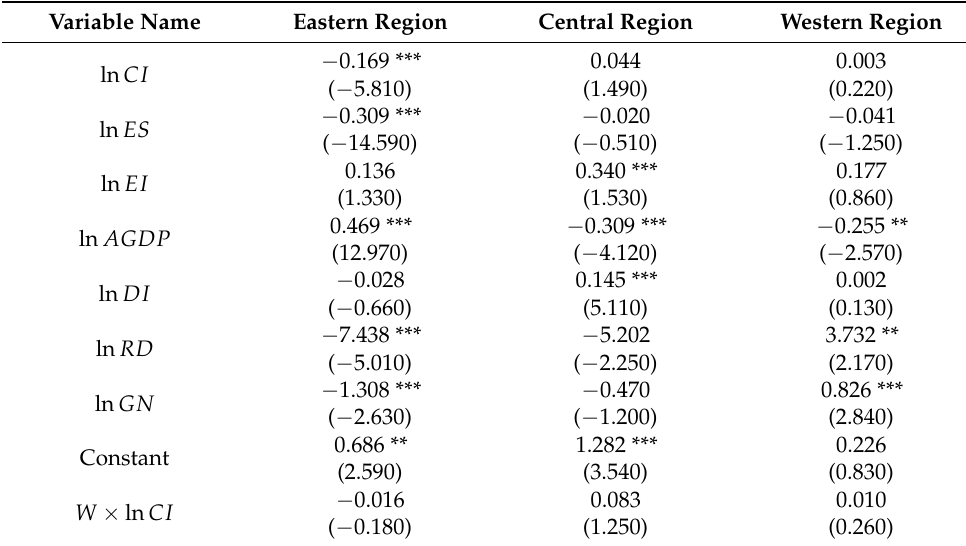
Table 9. Regression results of east, middle and west